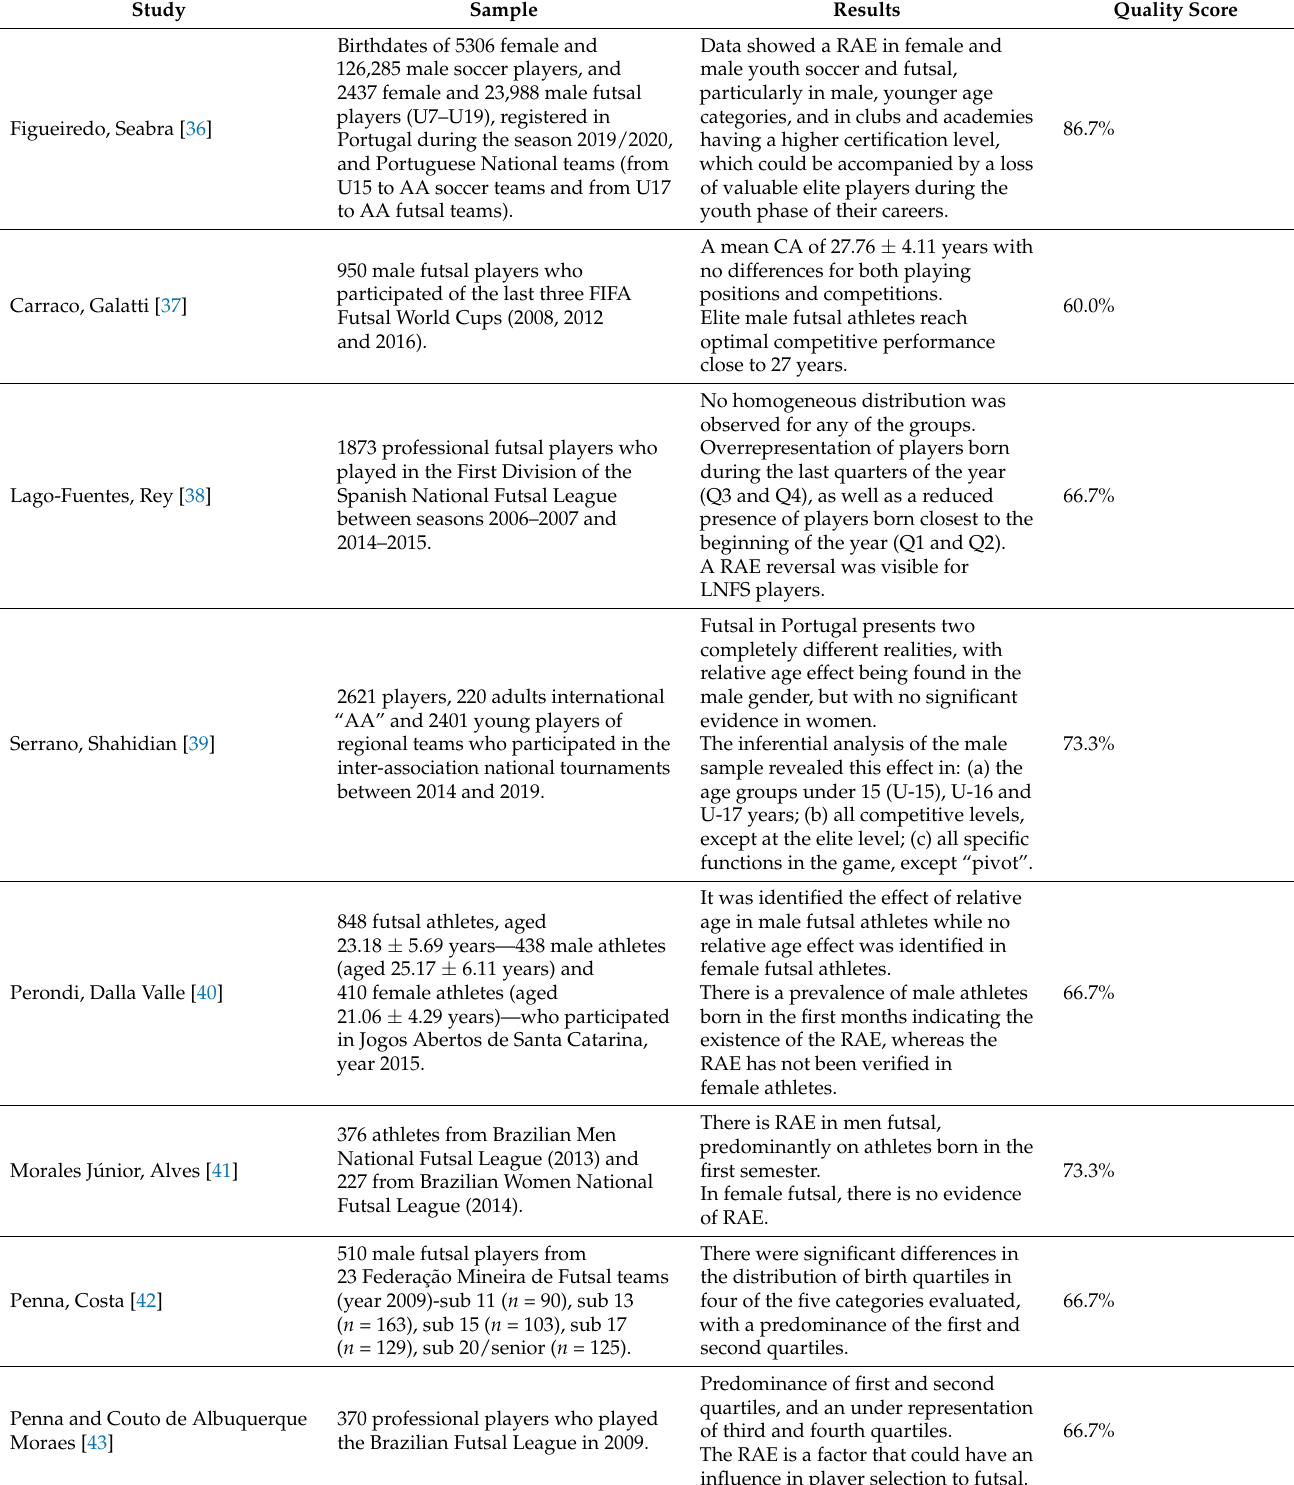
Table 7. Studies with predominantly relative age effect